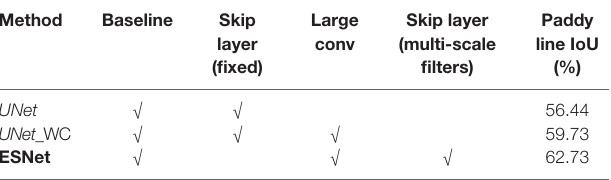
TABLE 4 | Ablation experiments to evaluate the effectiveness of the proposed extended skip connections. Method Baseline